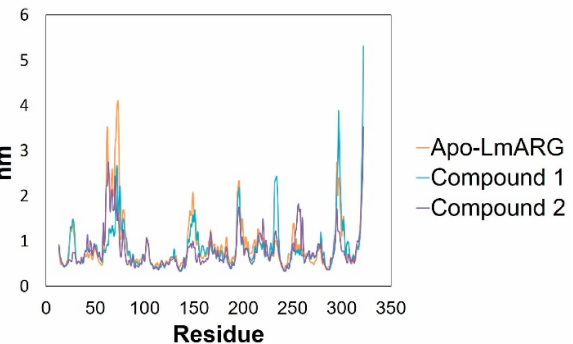
Figure 4. Root Mean Square Fluctuation analysis of C α in the Apo-LmARG and the respective complexes.